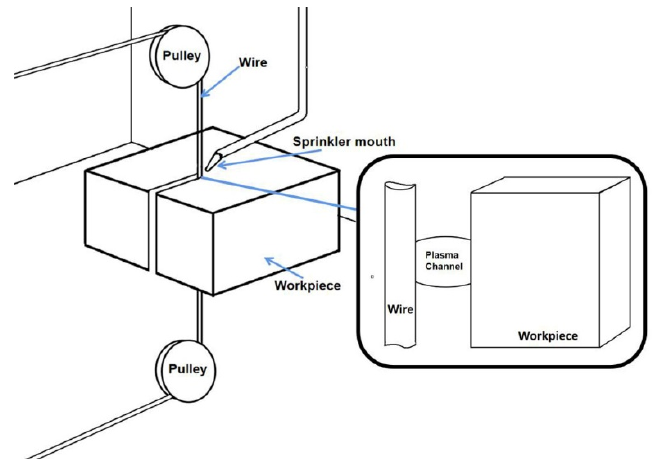
Figure 1. Wire Electrical Discharge Machining (WEDM) working principle.